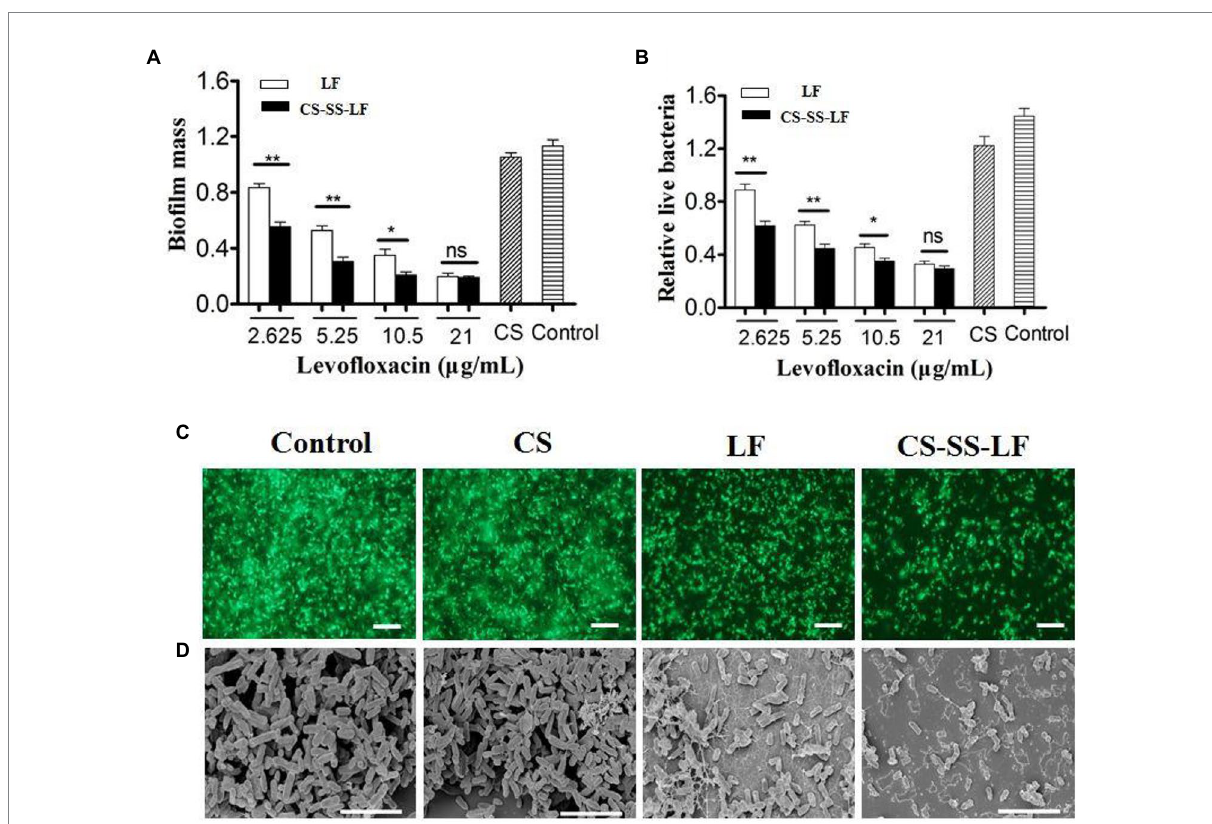
FIGURE 8 Antibiofilm activity of CS-SS-LF micelles. Crystal violet assay (A) and MTT assay (B) of Salmonella biofilm with CS, LF, and CS-SS-LF. Biofilms treated with CS-SS-LF are shown in the black bar, while those treated with LF are depicted in the white bar. (C) Fluorescence images of Salmonella biofilm, scale bar represents 10 μ M. (D) SEM images of Salmonella biofilm, scale bar represents 5 μ M. (* p < 0.05; ** p < 0.01; ns: not